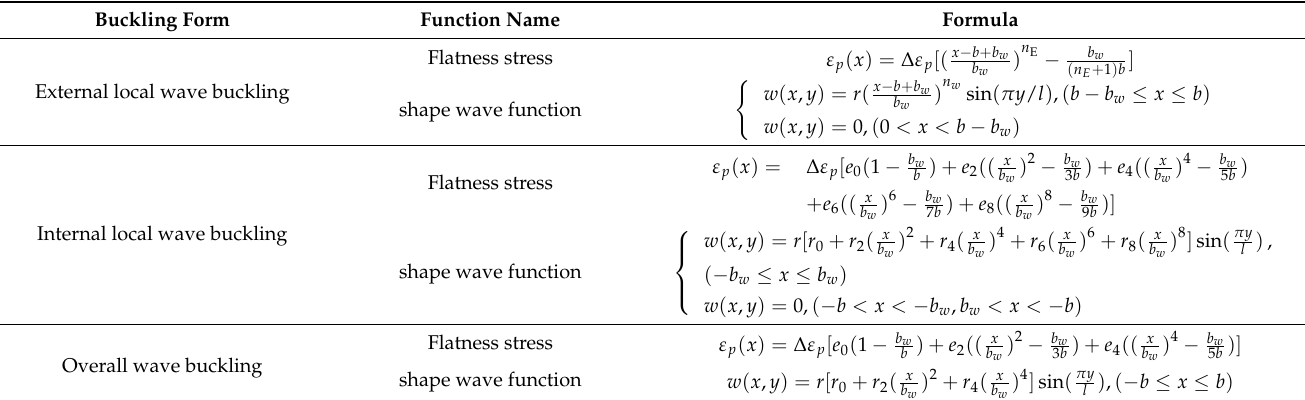
Table 1. The flatness stress and wave function of various bucking